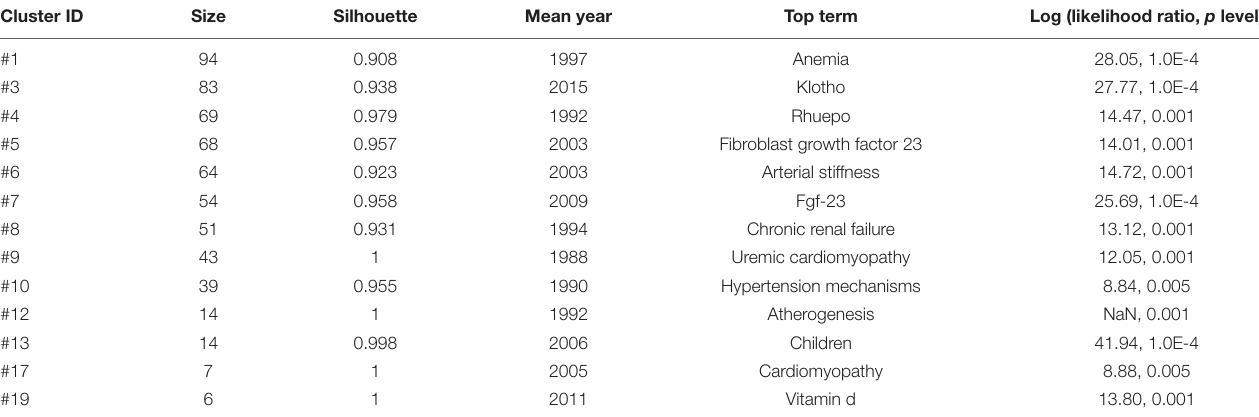
TABLE 6 | The 13 clusters of co-cited references with the higher K